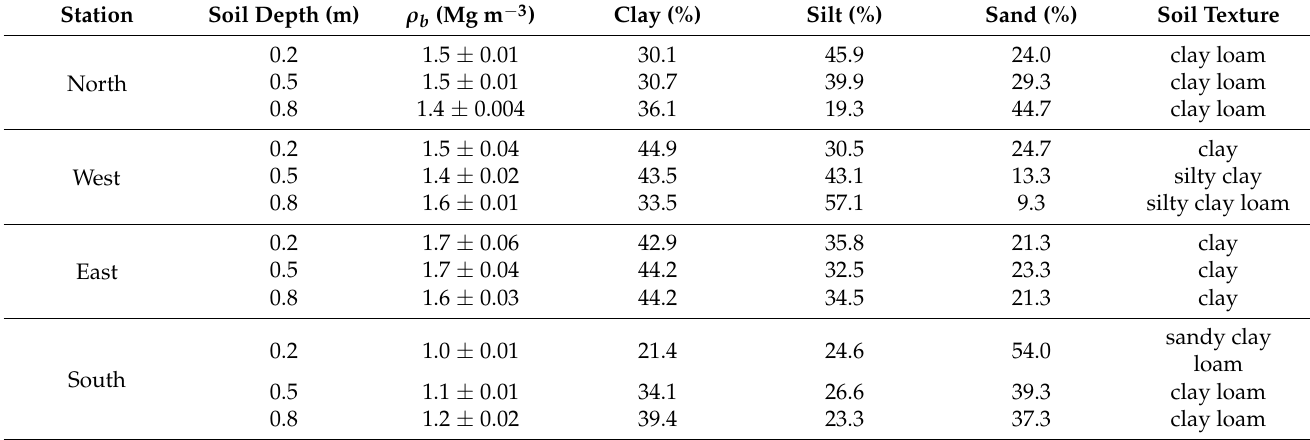
Table A1. Soil physical properties by monitoring station: by depth, including mean values and standard error of the three samples collected at each depth to determine dry soil bulk density ( ρ b ); soil particle distribution of sand, silt, and clay; and soil texture. Soil particle distribution was calculated using an aggregate of the three samples collected at each